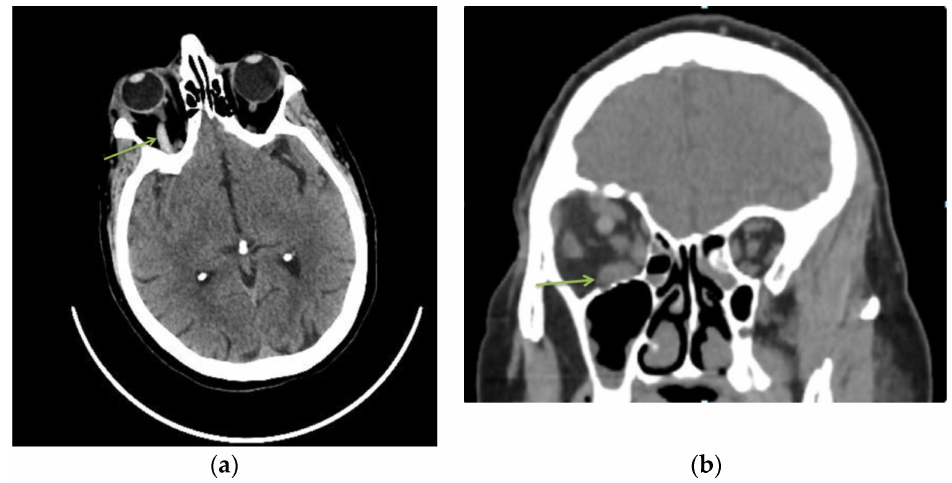
Figure 1. A 77-year-old woman, with hypertensive pathology, presented to the emergency department complaining of eye ptosis, chemosis and conjunctival congestion. The patient was known to have high myopia (both eyes) and amblyopia (LE). The ophthalmological examination revealed best- corrected visual acuity (BCVA) on the right eye 0.5 and 0.06 for left eye. Intraocular pressure (IOP) was 25 mmHg in RE and 14 mmHg in LE. The anterior segment of the left eye was normal. In the RE we noticed diffuse conjunctival congestion, chemosis and eyelid ptosis. Ocular movements were normal in both eyes. Pupillary light reflex was bilaterally intact. Hertel’s exophthalmometry revealed a proptosis of 20 mm in the right eye vs. 17 mm in the left eye. Non-contrast computed tomography (CT) of the brain and orbits revealed a hyperreflectivity at the level of the right ophthalmic vein ( a ) and inferior rectus muscle hypertrophy ( b ). Routine biochemical examination showed an increase of inflammatory markers (C-reactive protein, fibrinogen) and a high D-dimers value. Blood culture and a bacteriological conjunctival exam were negative. Additionally, other secondary causes were excluded (tumors, autoimmune diseases, infections). ( a ) Axial sections of non-contrast head CT scan—hyperreflectivity of the right ophthalmic vein. ( b ) Non-contrast head CT coronal scan—inferior rectus muscle